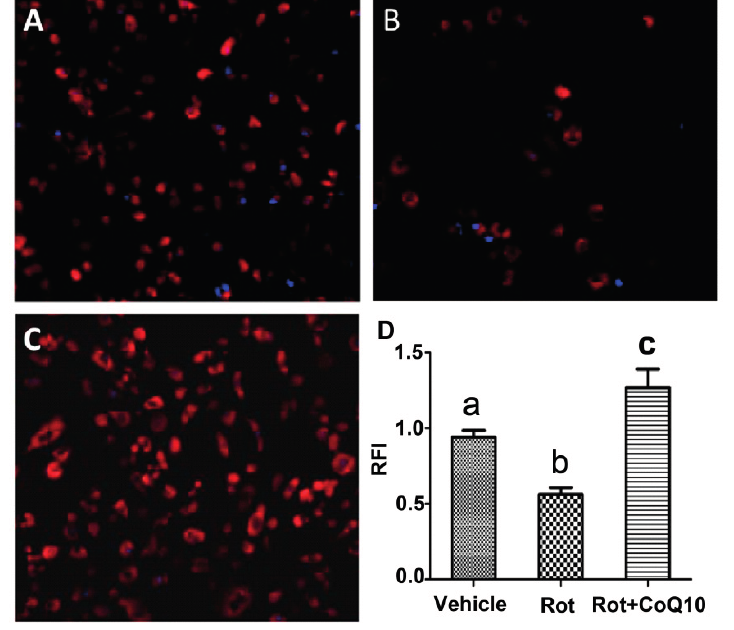
Figure 4. Mitochondrial membrane potential measured by TMRM. ( A – C ) representative images collected from ( A ) control, ( B ) rotenone-treated and ( C ) CoQ10 plus rotenone treated cells; ( D ) a summarized bar graph showing depolarization of mitochondrial membrane potential in rotenone-treated cells and preventive effect of CoQ10. Data were collected from 3 independent experiments and presented as means ± s.d. p < 0.01 b vs.